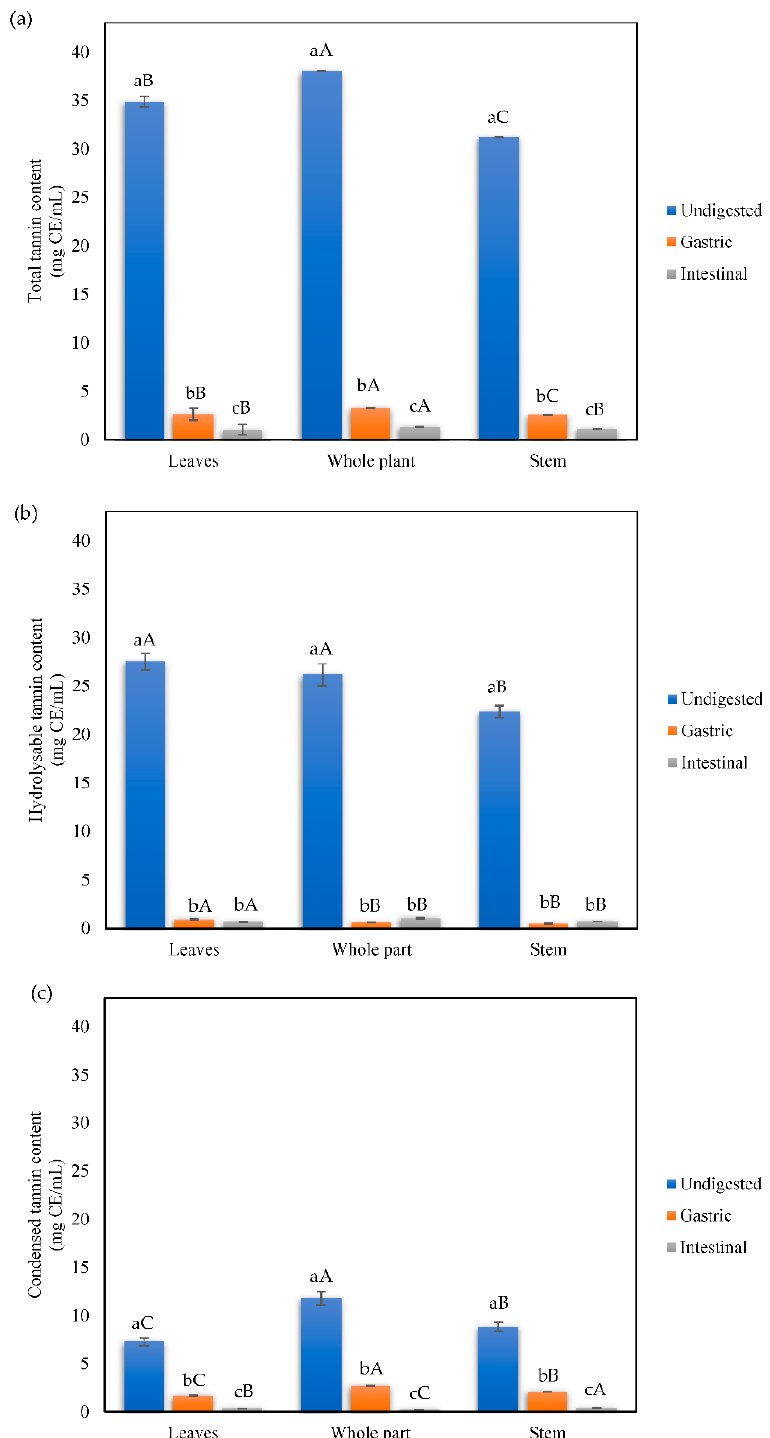
Figure 3. ( a ) Total, ( b ) hydrolyzable, and ( c ) condensed tannin content of mistletoe infusions subjected to simulated gastrointestinal digestion. Data shown as means ± SD values with at least three replicates (n = 3). Means that do not share lowercase letters are significantly different by the Tukey test ( p < 0.05). Means that do not share capital letters show statistical differences between values per plant part in each digestive phase by the Tukey test ( p <